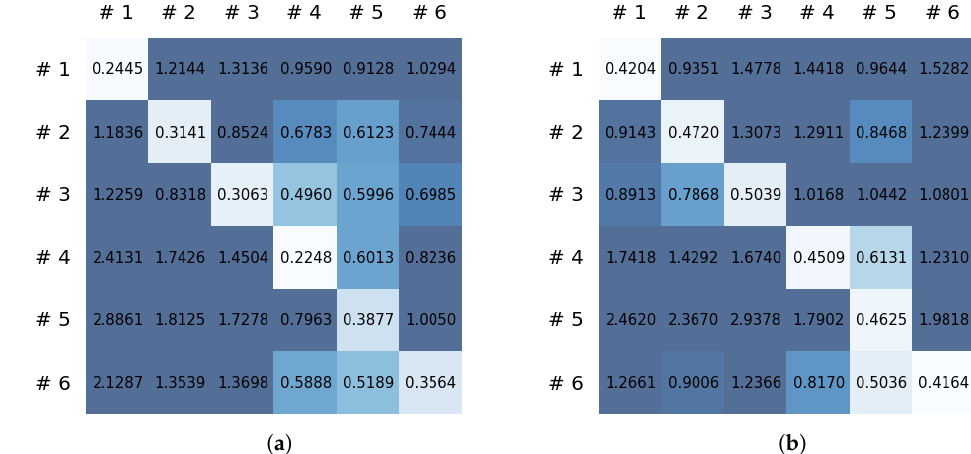
Figure 11. MSE values of the CNN model for ( a ) walking motions and ( b ) for running motions.